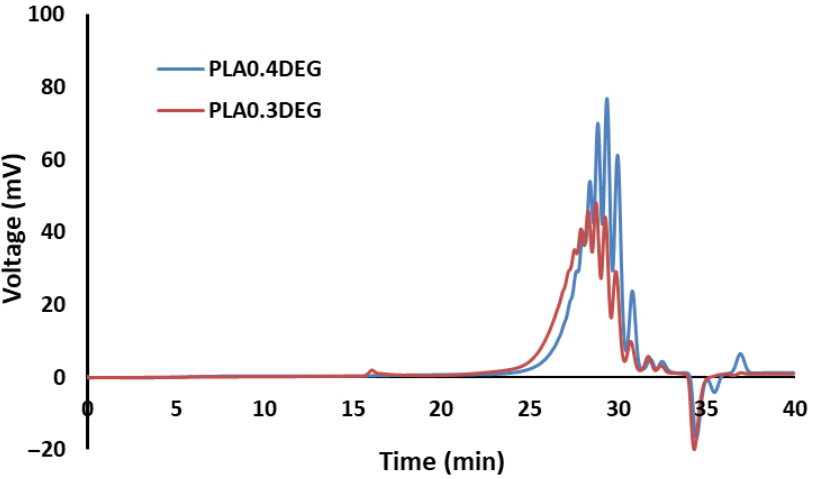
Figure 2. GPC chromatograms of eco-polyols based on waste PLA.